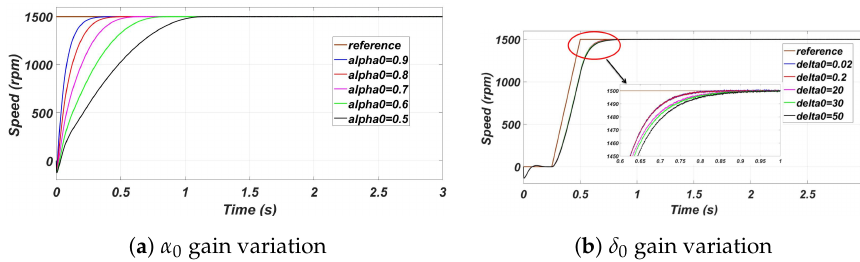
Figure 3. Control law